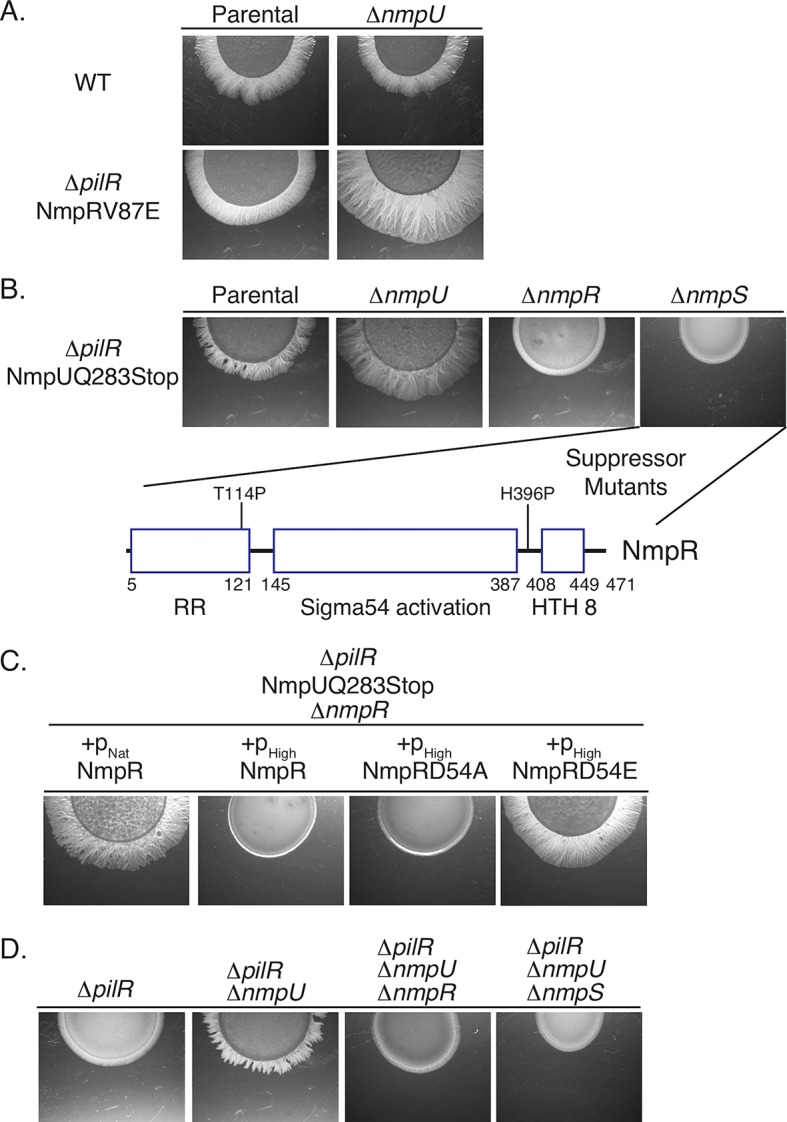
SK NmpU, RR-SK NmpS, and RR NmpR are in a single signaling pathway.Epistasis analysis demonstrates these signaling proteins are in a shared pathway. Mutations in various strains were constructed as depicted and motility assayed as before. Note especially that deletion of nmpR or nmpS is epistatic to a deleted or non-functional nmpU (B and D); that suppressor mutations in nmpR arose in the NmpUQ283Stop ΔnmpS strain (B and Fig 4); and that deletion of nmpU is sufficient to restore motility in the ΔpilR parental strain (D). As before, over-expression of a phosphomimetic (D54E) NmpR is necessary to restore motility of a ΔnmpR strain (C). The motility image of the parental NmpRV87E strain (A) is a representative image reproduced from Fig 3A.